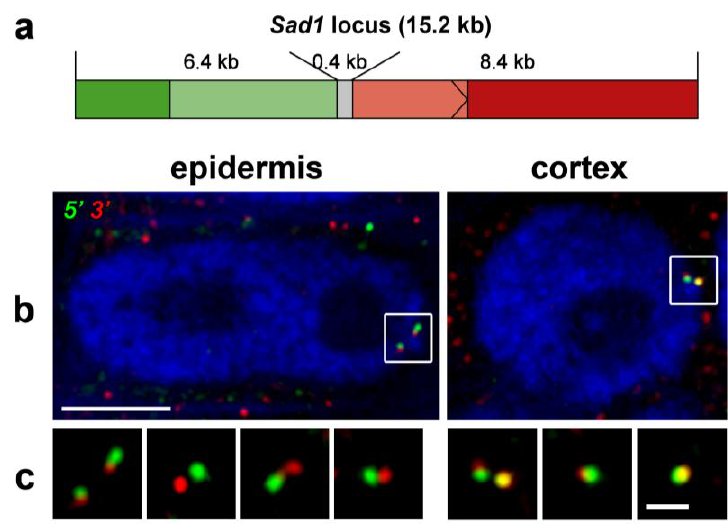
Figure 3. Decondensation of the Sad1 gene locus in oat root visualized using different coloured probes for the 5' and 3' ends of the gene. ( a ) Diagram of the labelling scheme used; the 5' portion is labelled in green, the 3' portion in red; ( b ) Examples of G2 nuclei from tissue labelled with the two probes. In the epidermal cells, where Sad1 is actively transcribed, the red and green ends of the gene can be seen to be separated, whereas they overlap to a much greater extent in the cortex cells, where Sad1 is not transcribed. Bar = 5 m; ( c ) A gallery of Sad1 double labelled sites from different nuclei. Bar = 1